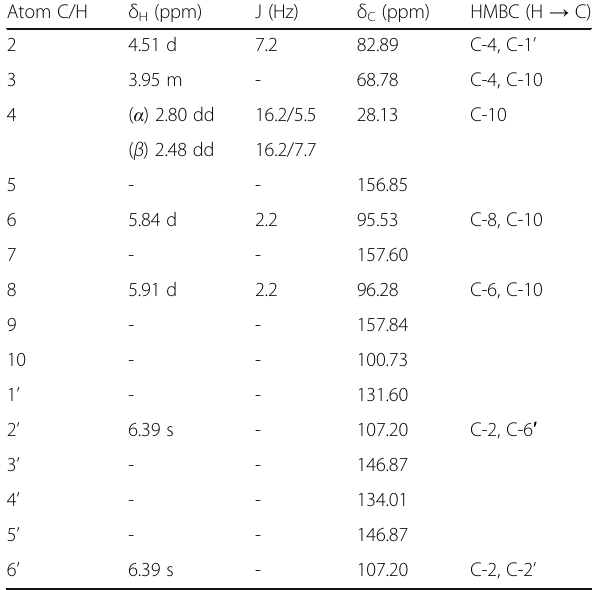
Table 2 Spectral determination of ( − )-gallocatechin in 1